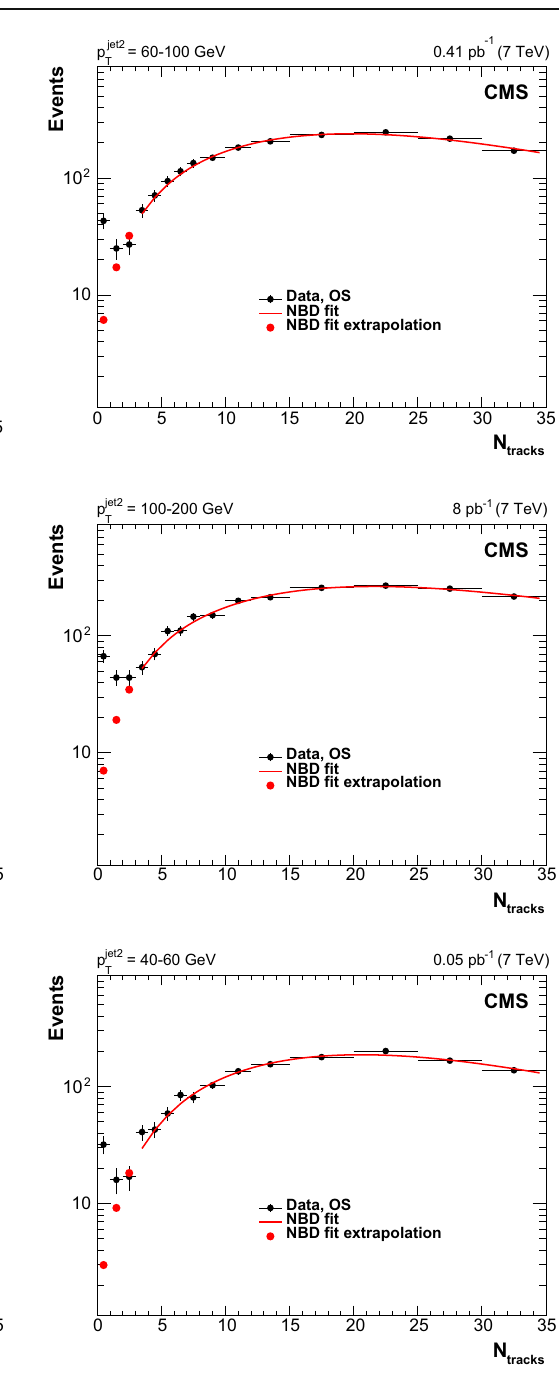
(left)togetherwiththe N tracks distributionofsame-side(SS)dijetevents (blue circles), and fitted to a NBD function T